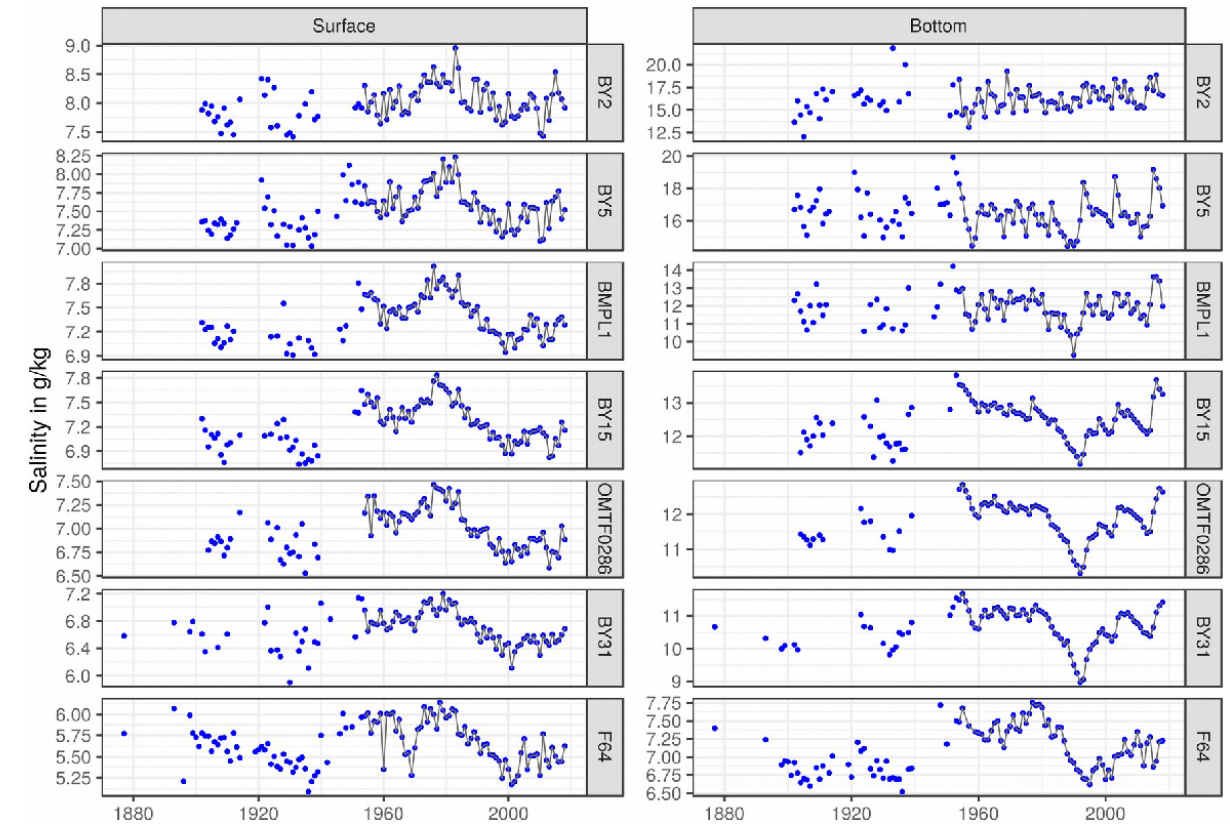
Figure 21. Annual mean values of deseasonalised daily sea surface (left column) and bottom (right column) salinity (blue dots) at seven important stations during 1877–2018. The grey lines show the period when every station has data for every year